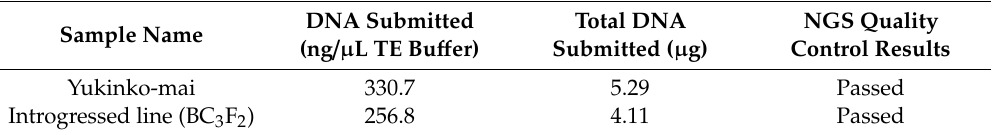
Table 2. Summary of DNA quality control (QC) results from